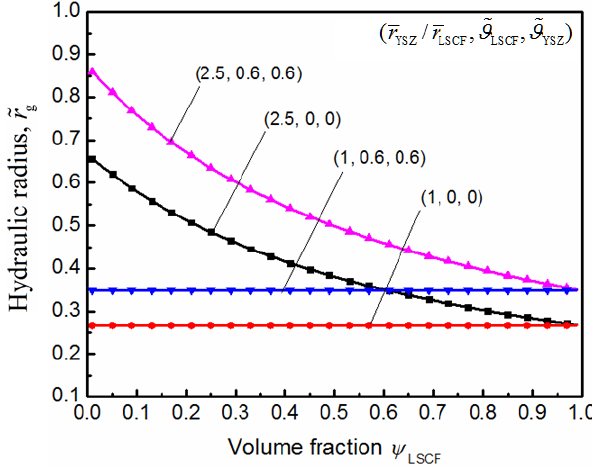
r as a function g